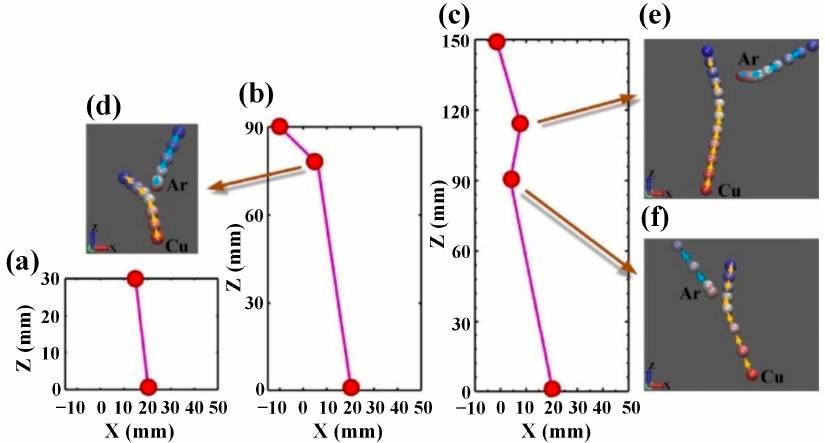
Figure 9. Trajectories of a sputtered atom in the gas phase at the target-substrate distances of ( a ) 30 mm, ( b ) 90 mm, and ( c ) 150 mm and the dynamic evolution of the elastic collisions between Cu and Ar atoms at the target-substrate distances of ( d ) 90 mm and ( e , f ) 150 mm. In sub-graphs ( a – c ), red balls denote the locations of the Cu atom, and purple lines represent the free flight trajectories of the Cu atom. In sub-graphs ( d – f ), the positions of Cu and Ar atoms at different time steps are presented by two strings of colored balls marked by yellow and blue arrows, respectively.